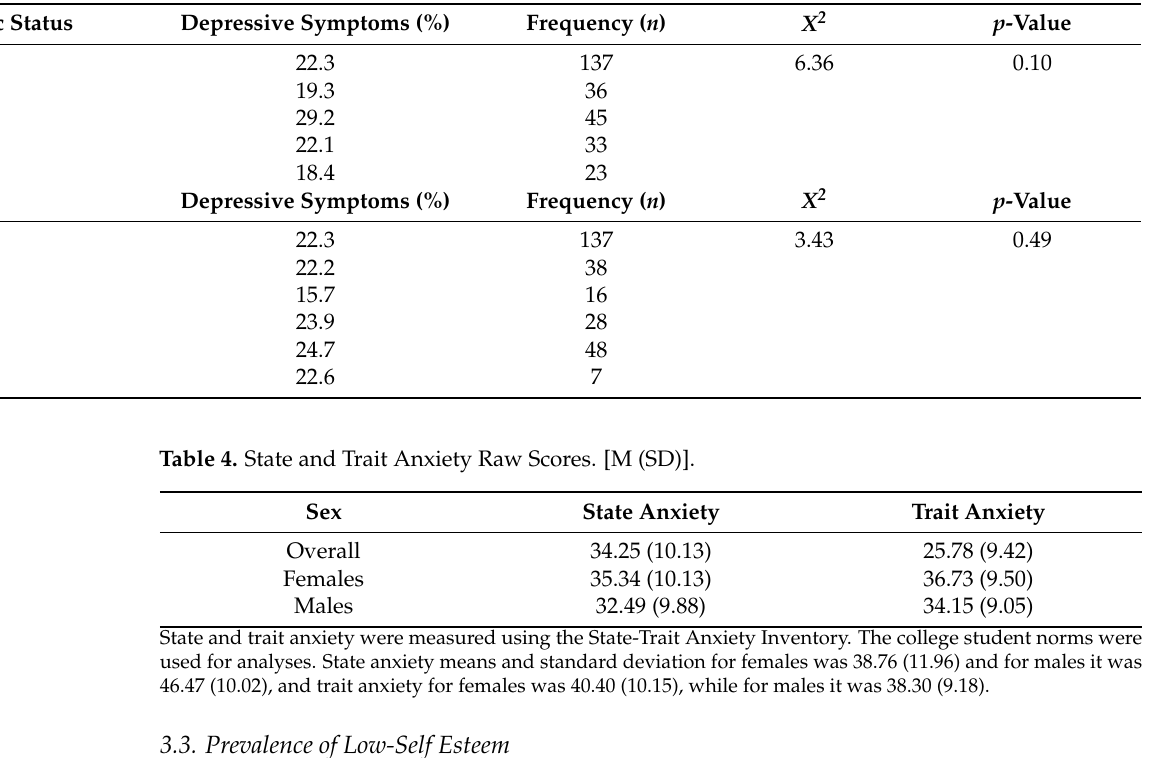
Table 3. Depression Prevalence by Academic Status and Sport.